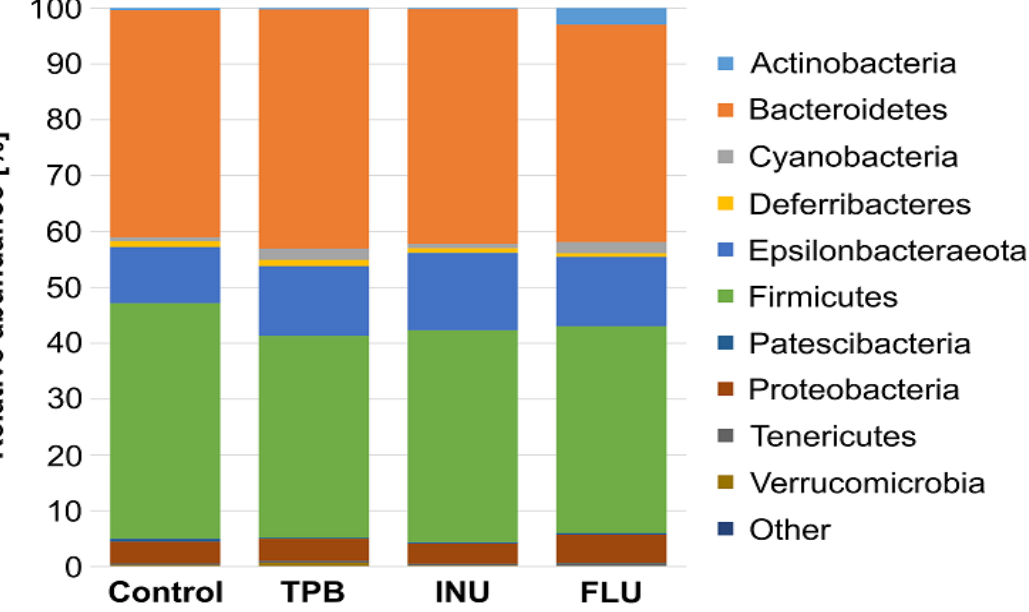
Figure 8. Relative abundance of bacterial phyla identified in tested groups of samples.